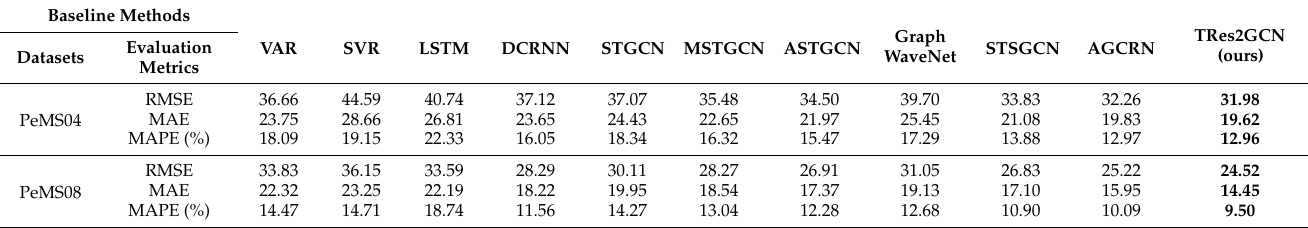
Table 2. Performance comparison of different traffic flow forecasting